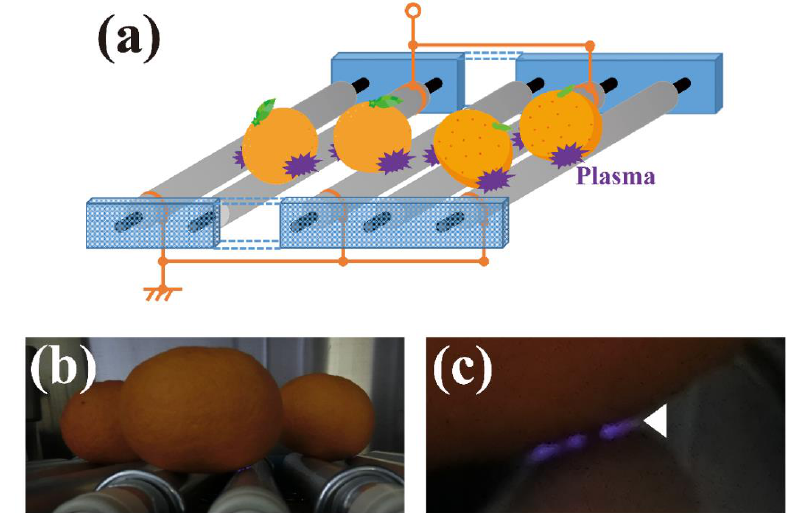
Figure 5. ( a ) Schematic representation of a roller conveyer plasma device for the continuous disinfection of fruits and vegetables using atmospheric pressure plasma. As an example, oranges are shown. ( b ) Oranges on rollers during operation of the device. ( c ) Enlarged image of ( b ) showing the plasma (Arrow) generated between the orange and roller during operation of the device. The image is modified from Toyokawa et al. 2017 [83] with permission from Elsevier.